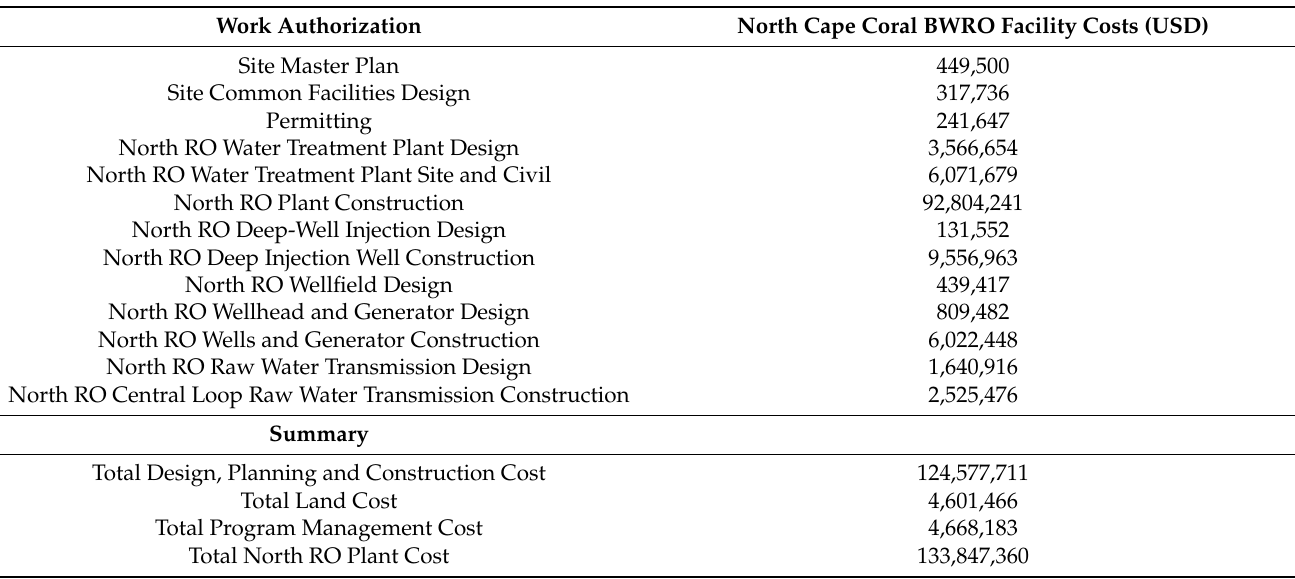
Table 1. Total CAPEX costs for the City of Cape Coral North RO Plant were constructed beginning in 2006 and completed in 2010. The initial capacity of the plant was 45,420 m 3 /day, with the facility designed to be expanded to 113,550 m 3